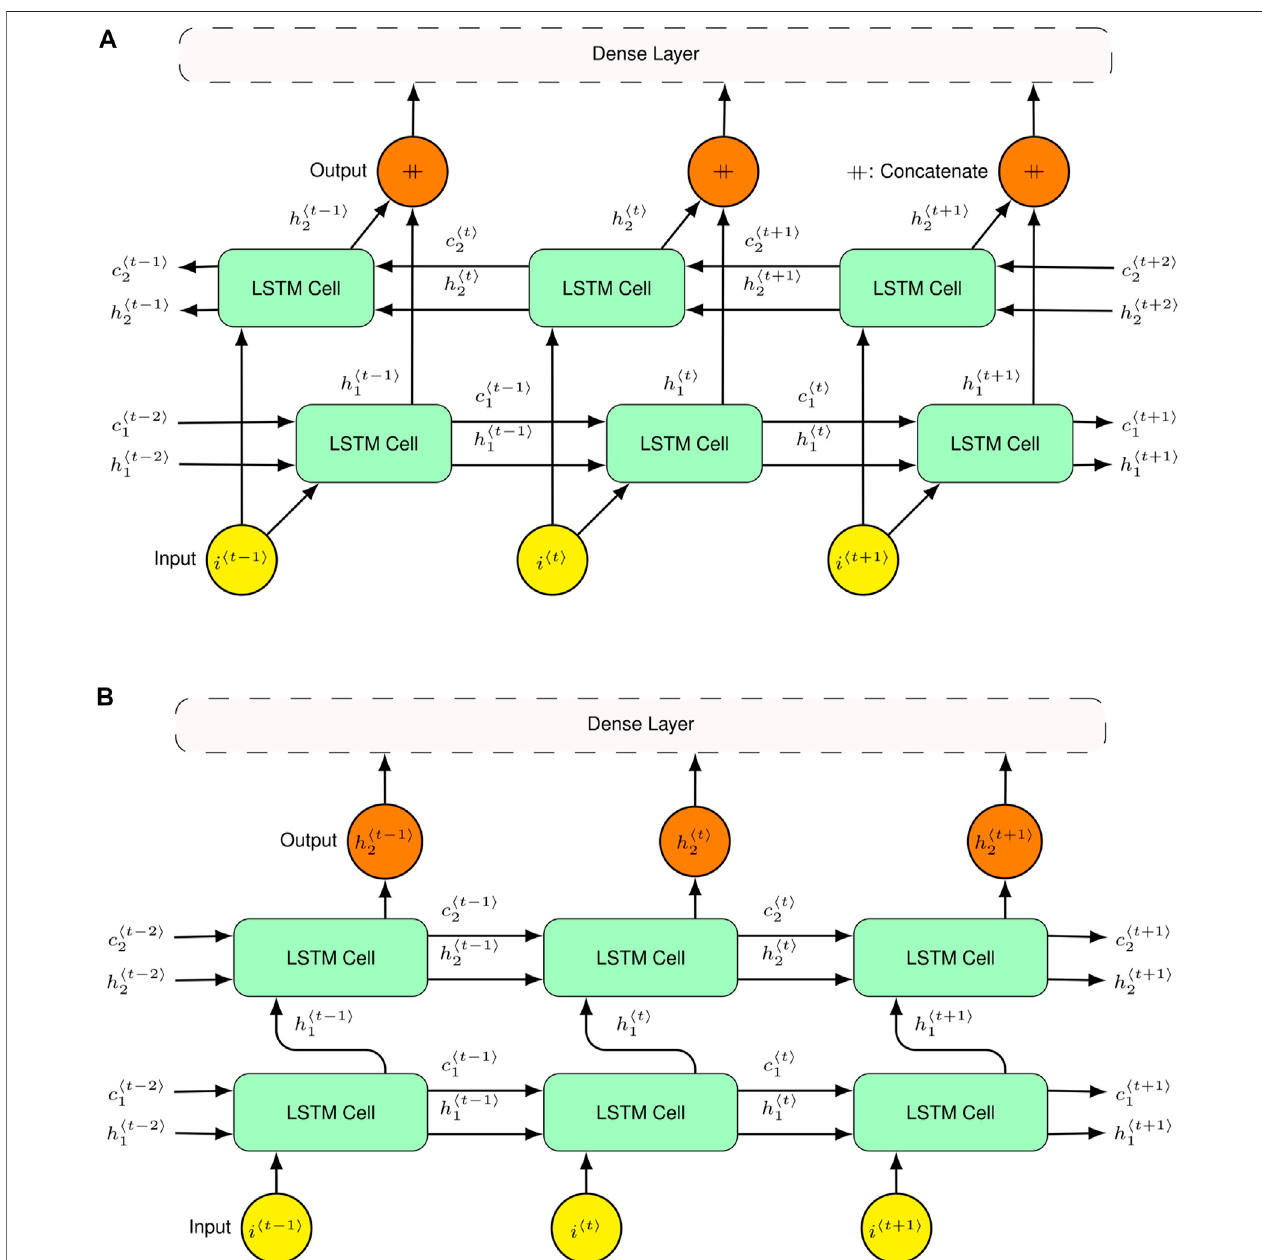
FIGURE 6 | (A) The structure of the Bi-LSTM. (B) The structure of a two-layer stacked LSTM. (C) The structure of the BS-LSTM.